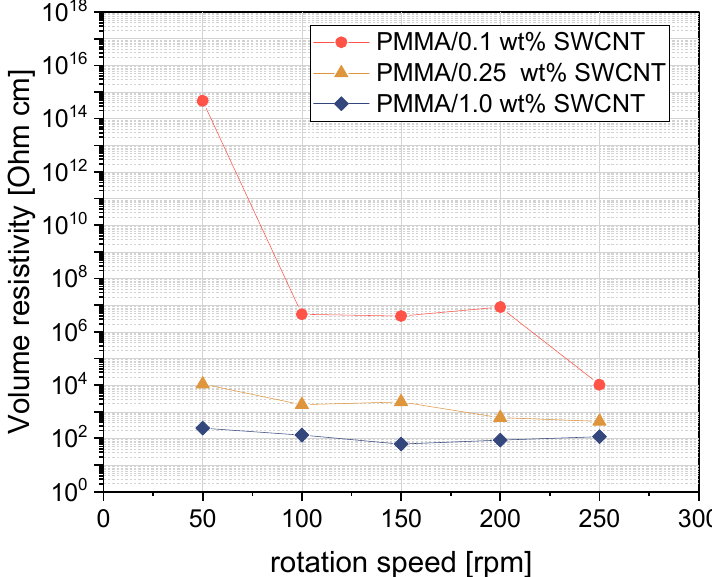
Figure 5. Electrical volume resistivity of PMMA/SWCNT composites prepared with the direct incorporation method at different rotation